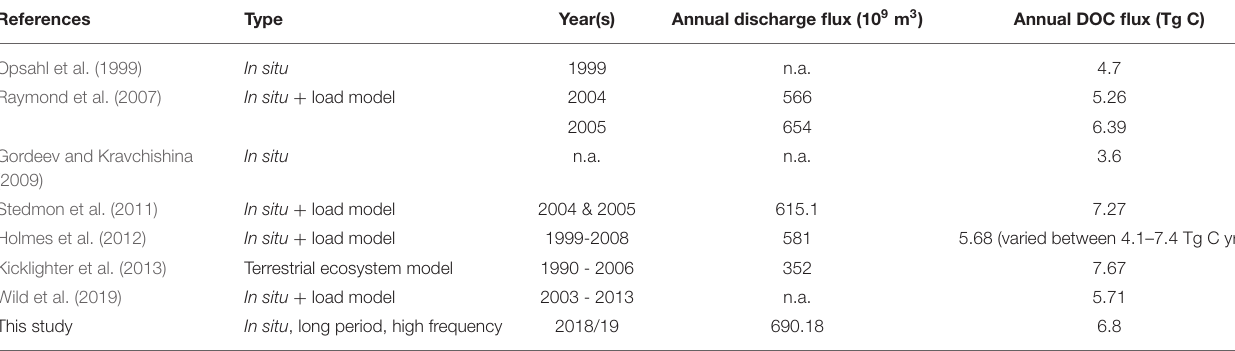
TABLE 4 | Previously published discharge and DOC fluxes and type of sampling and